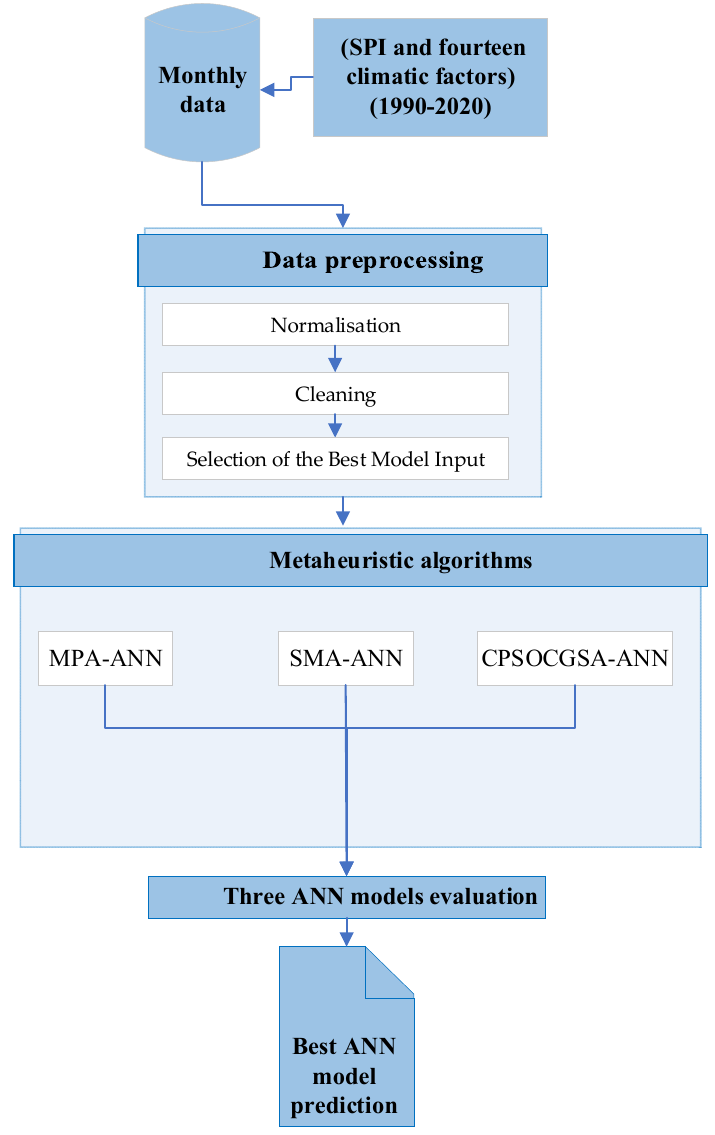
Figure 2. The suggested methodology for simulating drought (SPI 1, SPI 3, and SPI 6) depends on climatic factors.